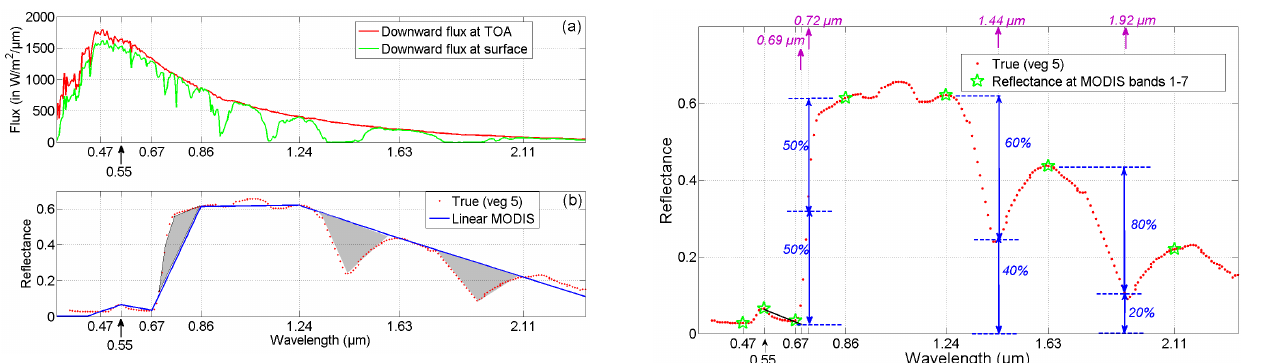
Fig. 5. This figure illustrates four auxiliary channels and the ratios used to determine the MODIS enhanced surface albedo (MEVA), where the x-axis represents wavelength (from 0.3 to 2.35µm) la- beled with MODIS bands 1–7 on the bottom and four auxiliary channels (0.69, 0.72, 1.44, and 1.92µm) at the top. Dotted red curve (“true”) represents the reflectance spectrum as shown in Fig. 2; the green stars present the corresponding reflectance at MODIS bands 1–7. The reflectance at the four auxiliary channels are determined as: at 0.69µm, the reflectance is obtained by linearly extrapolating the reflectance at 0.55 and 0.67µm; at 0.72µm, the reflectance is the average of the reflectance at 0.69 and 0.86µm; at 1.44µm, the reflectance is 40% of the reflectance at 1.24µm; at 1.92µm, the re- flectance is 20% of the reflectance at